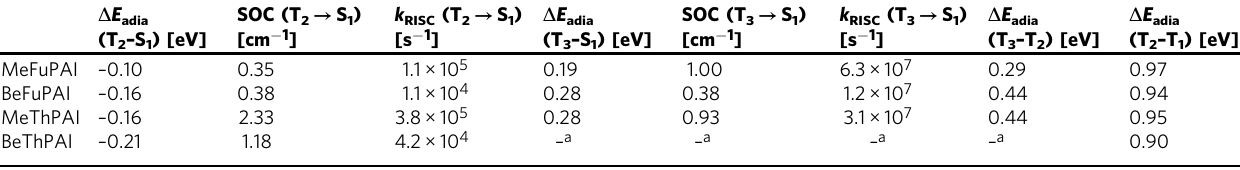
Table 2 Overview of excited state energies, spin – orbit coupling, and transfer rates obtained from theoretical